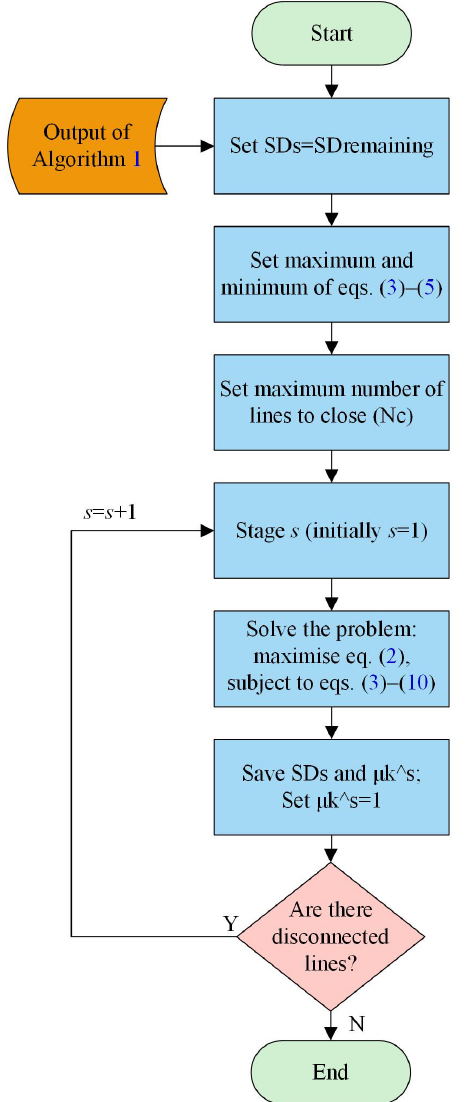
Figure 5. Flowchart of Algorithm